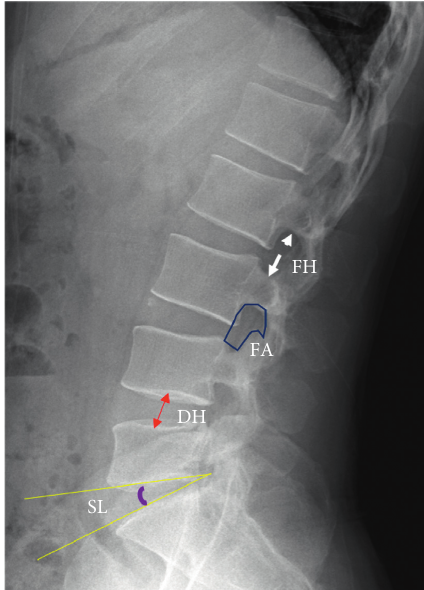
Figure 2: Illustration of the radiological measurement based on X-rays. FH: foraminal height; DH: disc height; FA: foraminal area; SL: segmental lordosis.